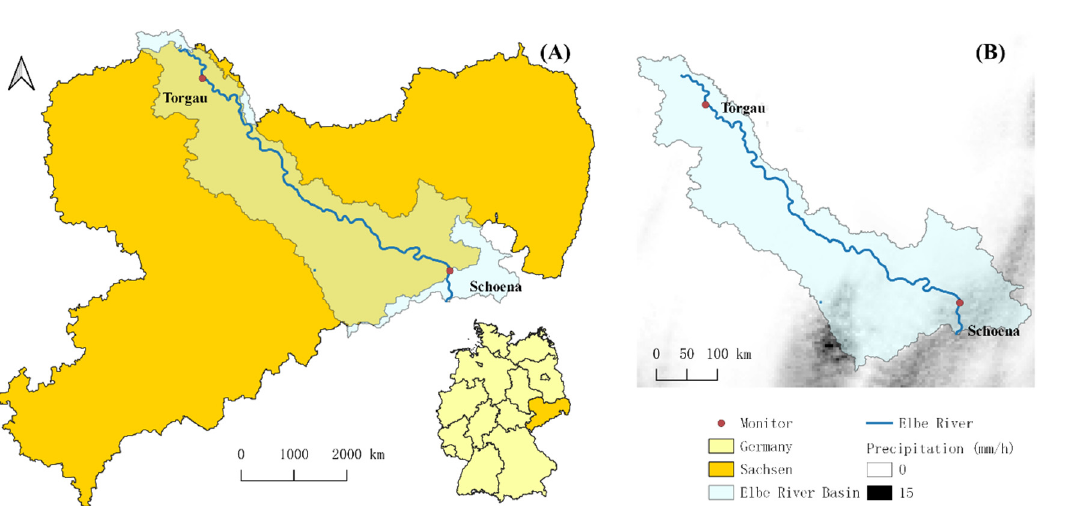
Figure 1. Study area and precipitation radar map. ( A ) The Elbe River flows into Sachsen, Germany, from Schoena, and flows out of Sachsen from Torgau. ( B ) An example of the precipitation radar map in this study